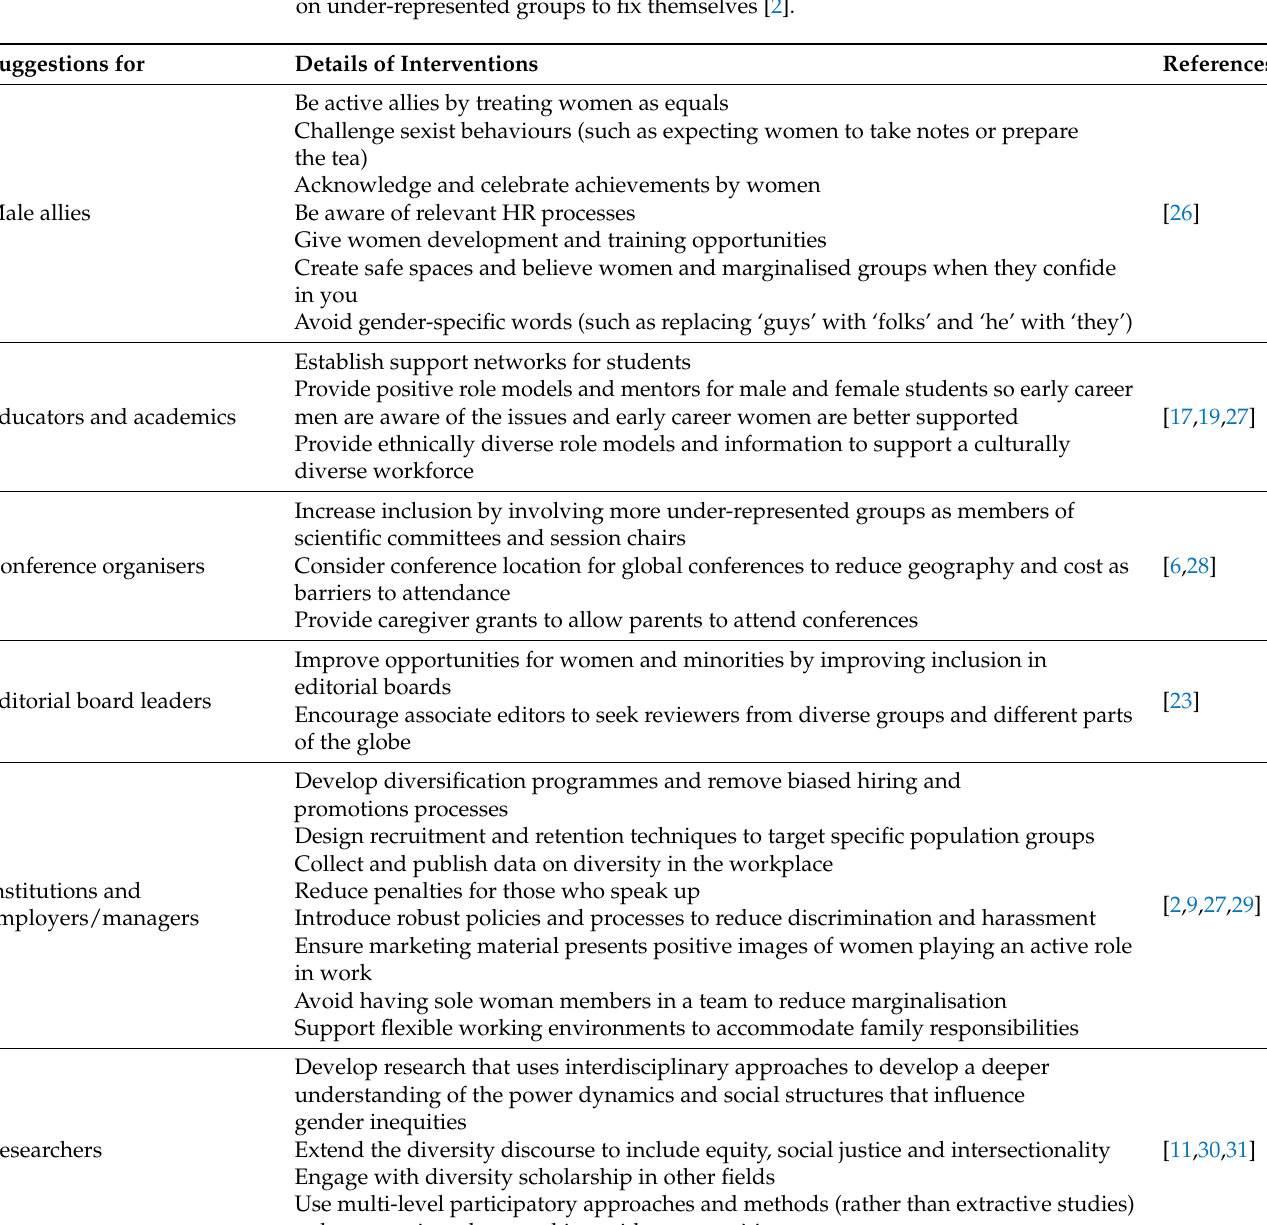
Table 1. Some suggested interventions to address gender bias in the forest sector. We have avoided making suggestions for women and marginalised people because we believe the onus should not be on under-represented groups to fix themselves